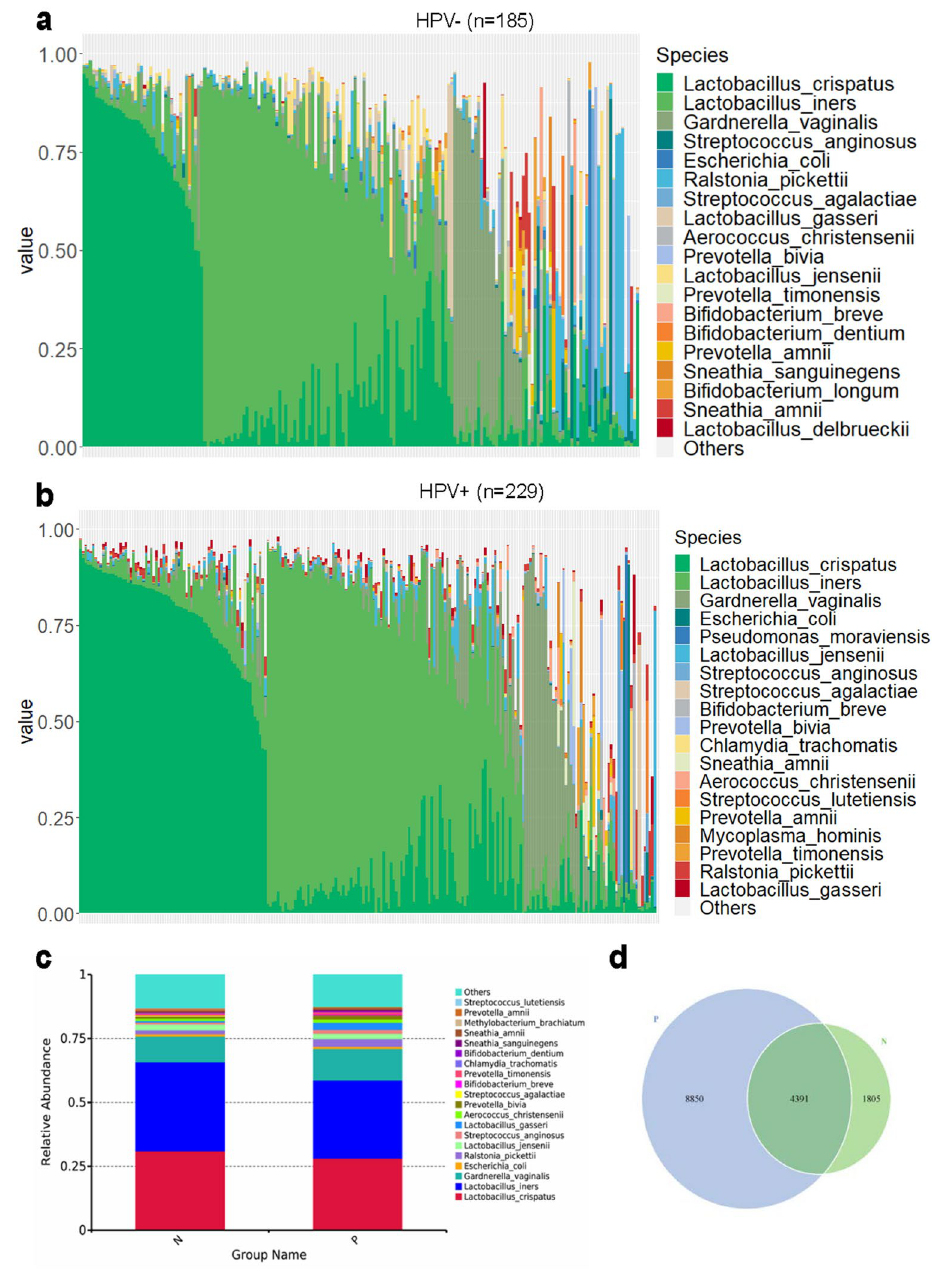
Figure 2. Vaginal microbiota composition in HPV-negative (HPV−) and HPV- positive (HPV +) group samples. ( a ). Relative abundance of the top 19 vaginal microbiota at the species level in HPV-negative group women. ( b ). Relative abundance of the top 19 vaginal microbiota at species level in HPV-positive group women. ( c ). Relative abundance bar chart for HPV-negative and HPV-positive groups at the species level. ( d ). Venn graph for HPV-negative and HPV-positive groups. Each circle represents a group, and the number of circles and overlapping parts represents the number of OTUs shared between the groups and the number of non- overlapping parts represents the number of unique OTUs of the group. P: HPV-positive; N: